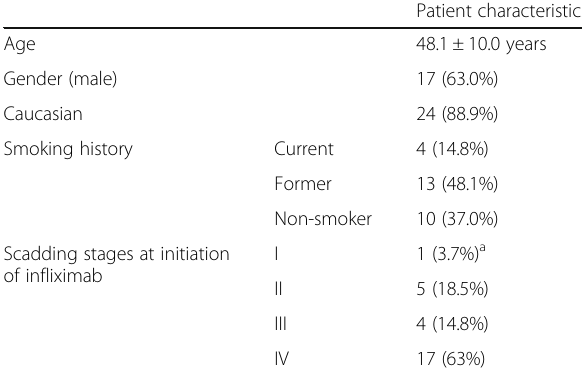
Table 1 Characteristics of patients, n = 27